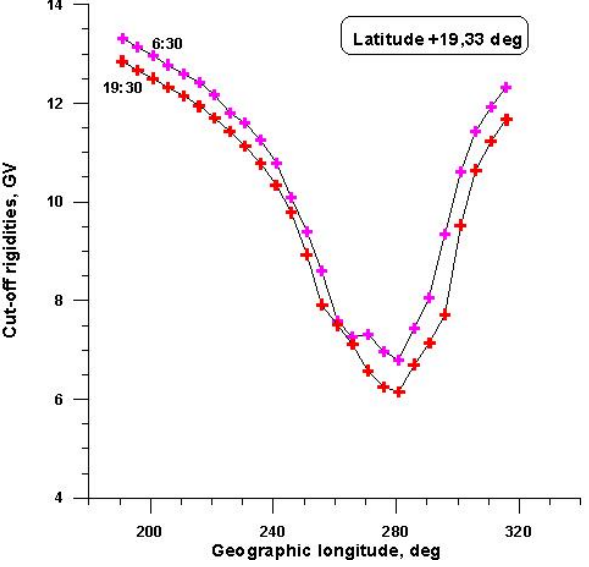
Fig. 3. Variations of the cutff rigidity along the geographic meridian of the Mexico station for the quiet conditions (pink) and at the peak of the magnetic storm on 20 November 2003 (red). Figure 4. Variations of the cutoff rigidity along the geographic meridian of the Mexico Figure 3. Variations of the cutoff rigidity along the geographic parallel of the Mexico station for the quiet conditions (pink) and at the peak of magnetic storm on 20 November 2003 (red).